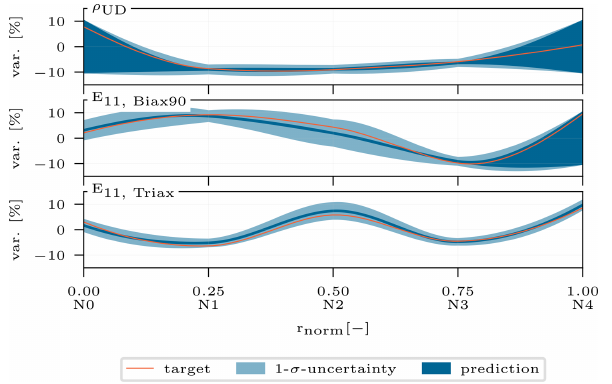
Figure 15. Exemplary inferred spline prediction range for ρ UD , E 11 , Biax90 , and E 11 , Triax . The graphs depict the target spline in orange, the mean prediction in dark blue, and the 1 σ uncertainty in light blue, for the updated spline